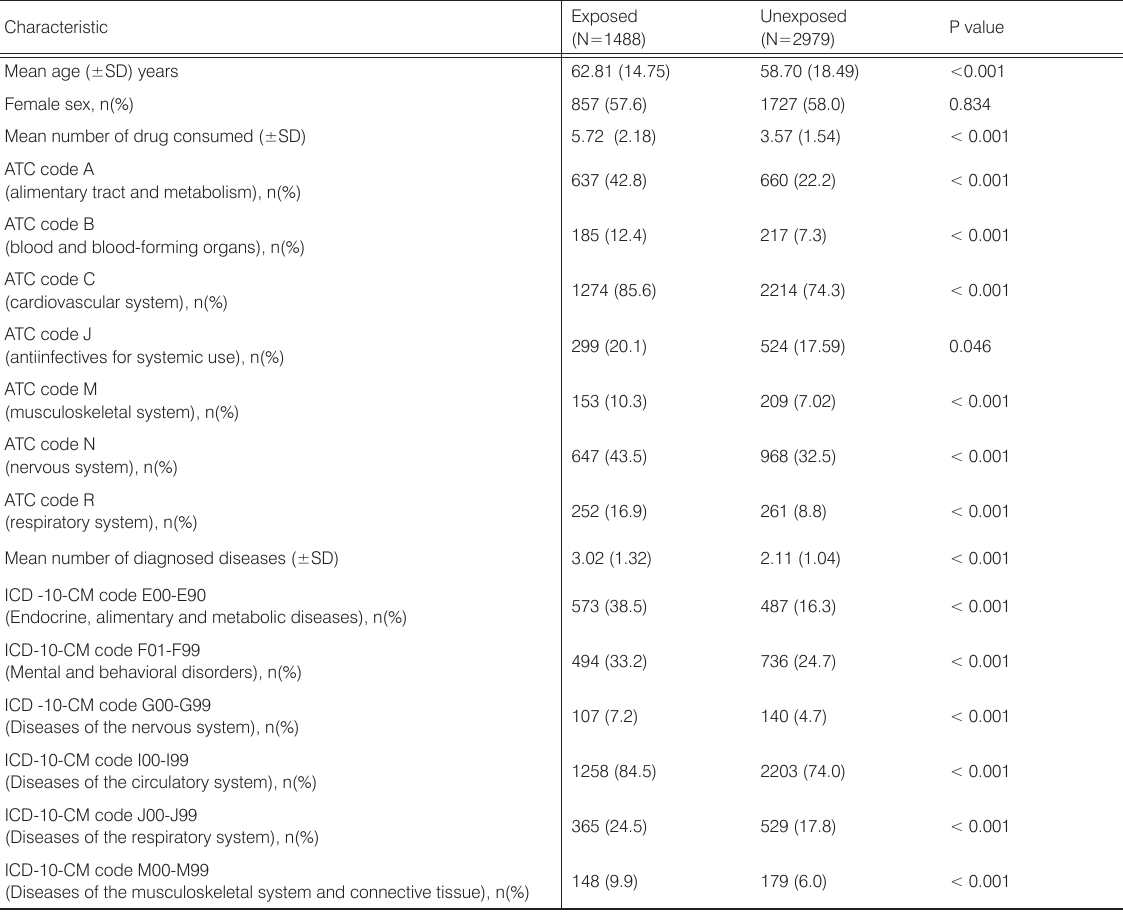
Table 1. General characteristics according to exposure to clinical significant potential drug-drug interactions